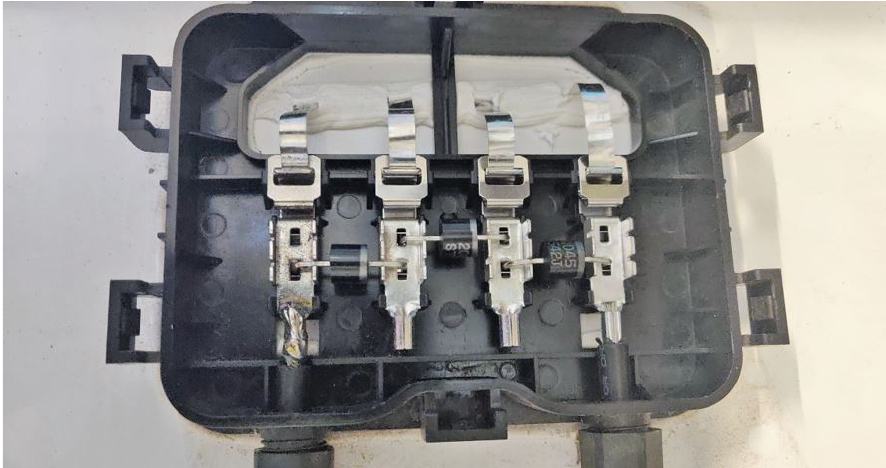
Figure 4. The opened junction box of a BYD 310P6C-36 72 cell PV module, showing the connections of three bypass